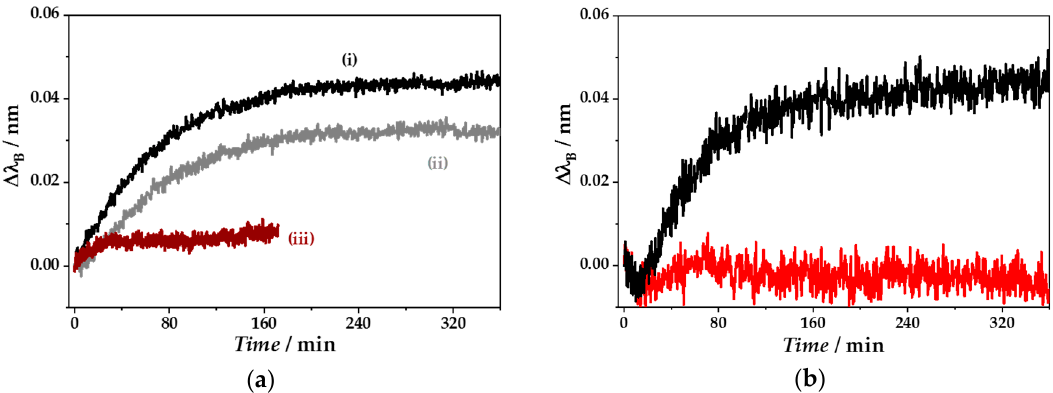
Figure 8. ( a ) Online monitoring of ∆ λ B during the fiber biofunctionalization steps including (i) silanization with (3-glycidyloxypropyl)trimethoxysilane (GOPTS) (black), (ii) coupling of the C-reactive protein (CRP)-specific single-stranded DNA aptamer as recognition element (grey), and (iii) blocking treatment with L-cysteine (brown). ( b ) Online monitoring of ∆ λ B during silanization with GOPTS of an etched (black) and non-etched grating (red) within the same fiber.